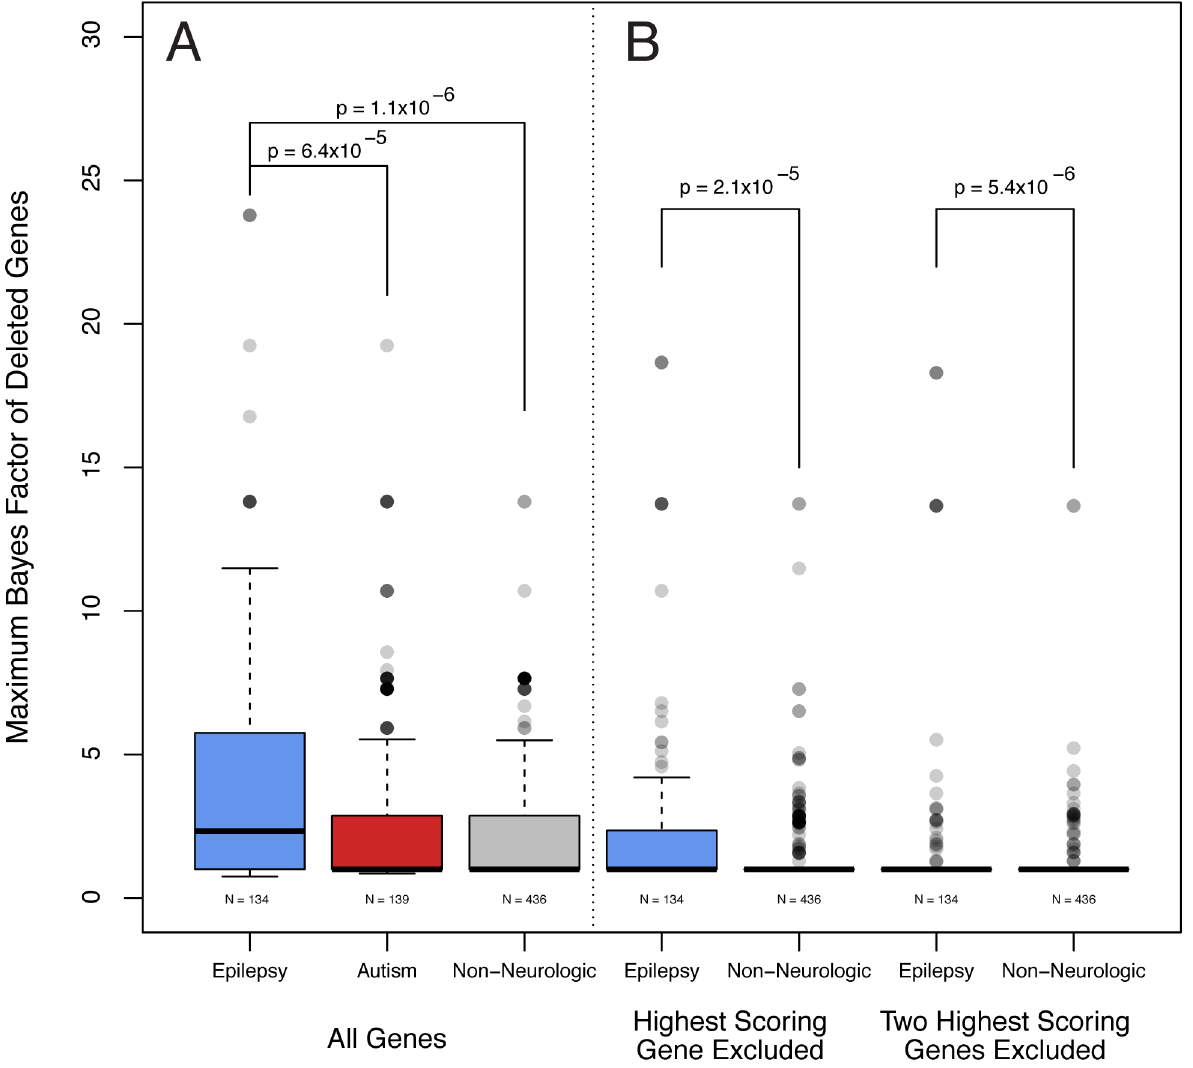
Figure 5. Epilepsy gene load is higher among subjects with epilepsy. A. Analogous to pathogenicity scores alone, the maximum Bayes factor of deleted genes was significantly higher among subjects with epilepsy versus non-neurologic comparators (Wilcox signed rank test, p , 1.1 6 10 2 6 ). Bayes factors are also higher among subjects with epilepsy compared with those referred for autism spectrum disorders (Wilcox signed rank test, p , 6.4 6 10 2 5 ). B. We performed the same calculation but excluded the contribution of the gene with the single highest Bayes factor from each patient. Genes with the second highest Bayes factors are significantly higher among subjects with epilepsy compared with individuals referred for non-neurologic indications (Wilxcox signed rank test, p , 2.1 6 10 2 5 ). A similar test for the third highest are genes was also